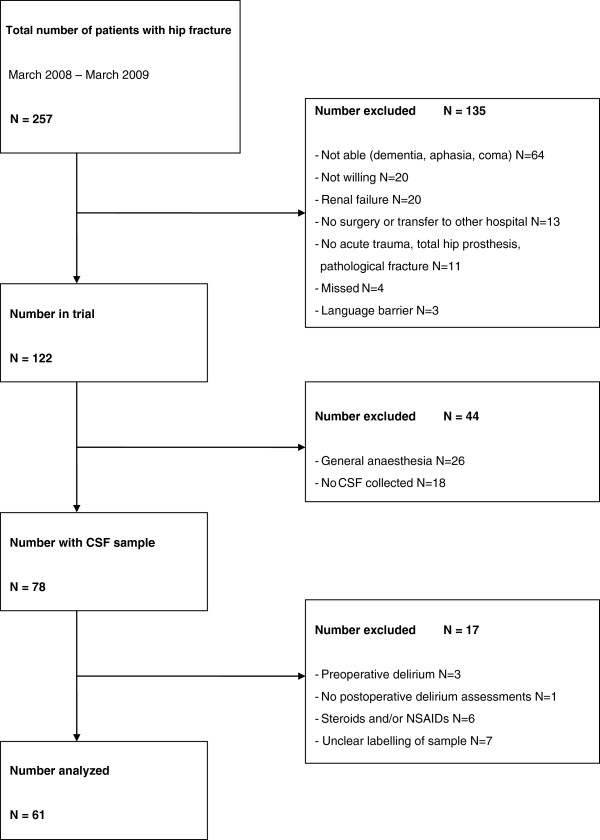
Flowchart of study inclusion.